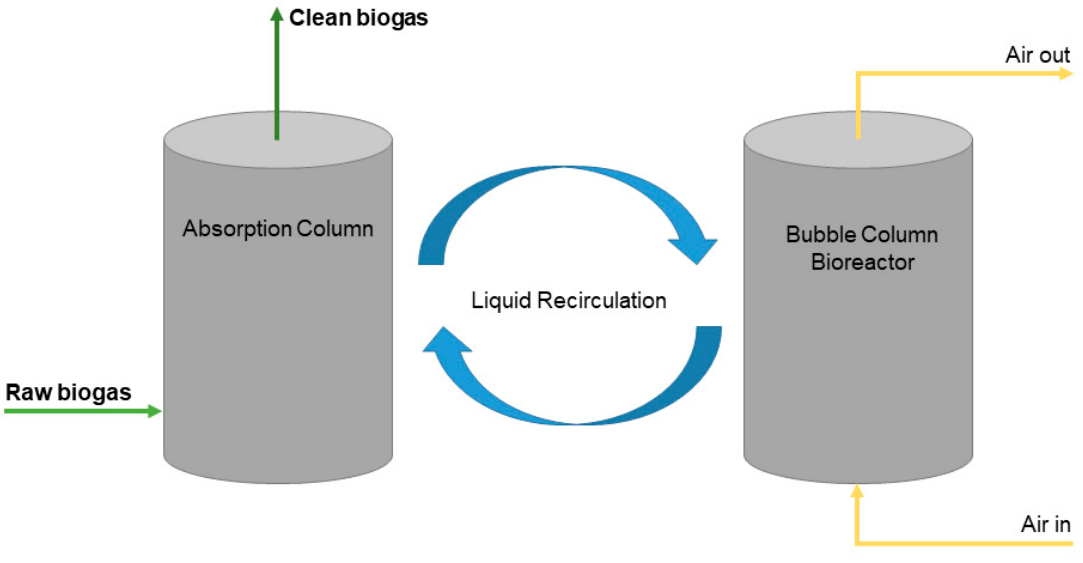
Figure 6. Fully Aerobic Biological Scrubber layout. Adapted with permission from 1 [90]; published by Elsevier, 2019. Table 7. Comparison of the main aspects affecting the use of Water, Organic, Chemical, and Biological